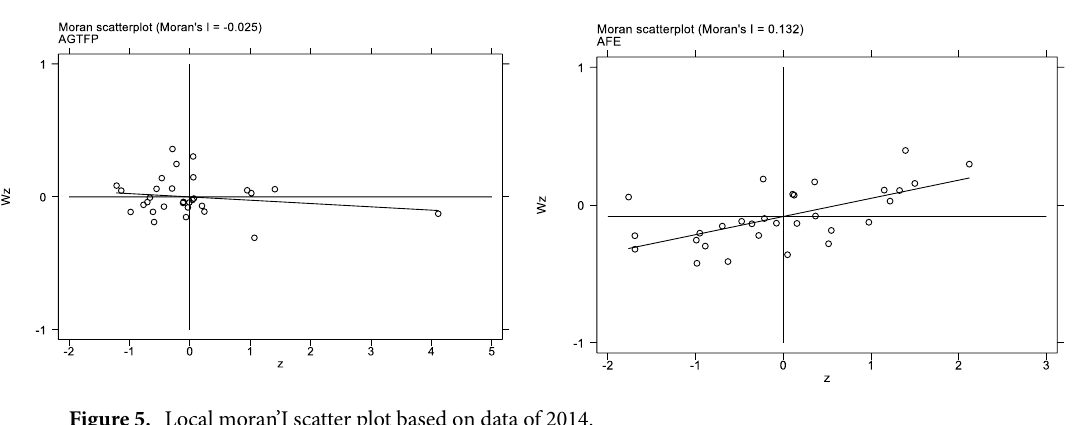
Figure 5. Local moran’I scatter plot based on data of